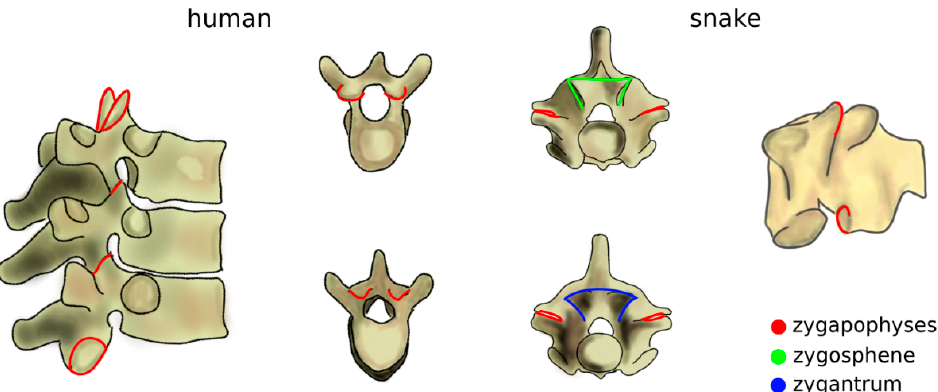
Figure 4. Zygapophyses (in red) in the human thoracic spine (left) and in a snake vertebra (right). In the latter, the zygosphene–zygantrum joints are also highlighted (in green and blue). Top: cranial view; bottom; caudal view. Part of the figure was adapted from Reference [49].